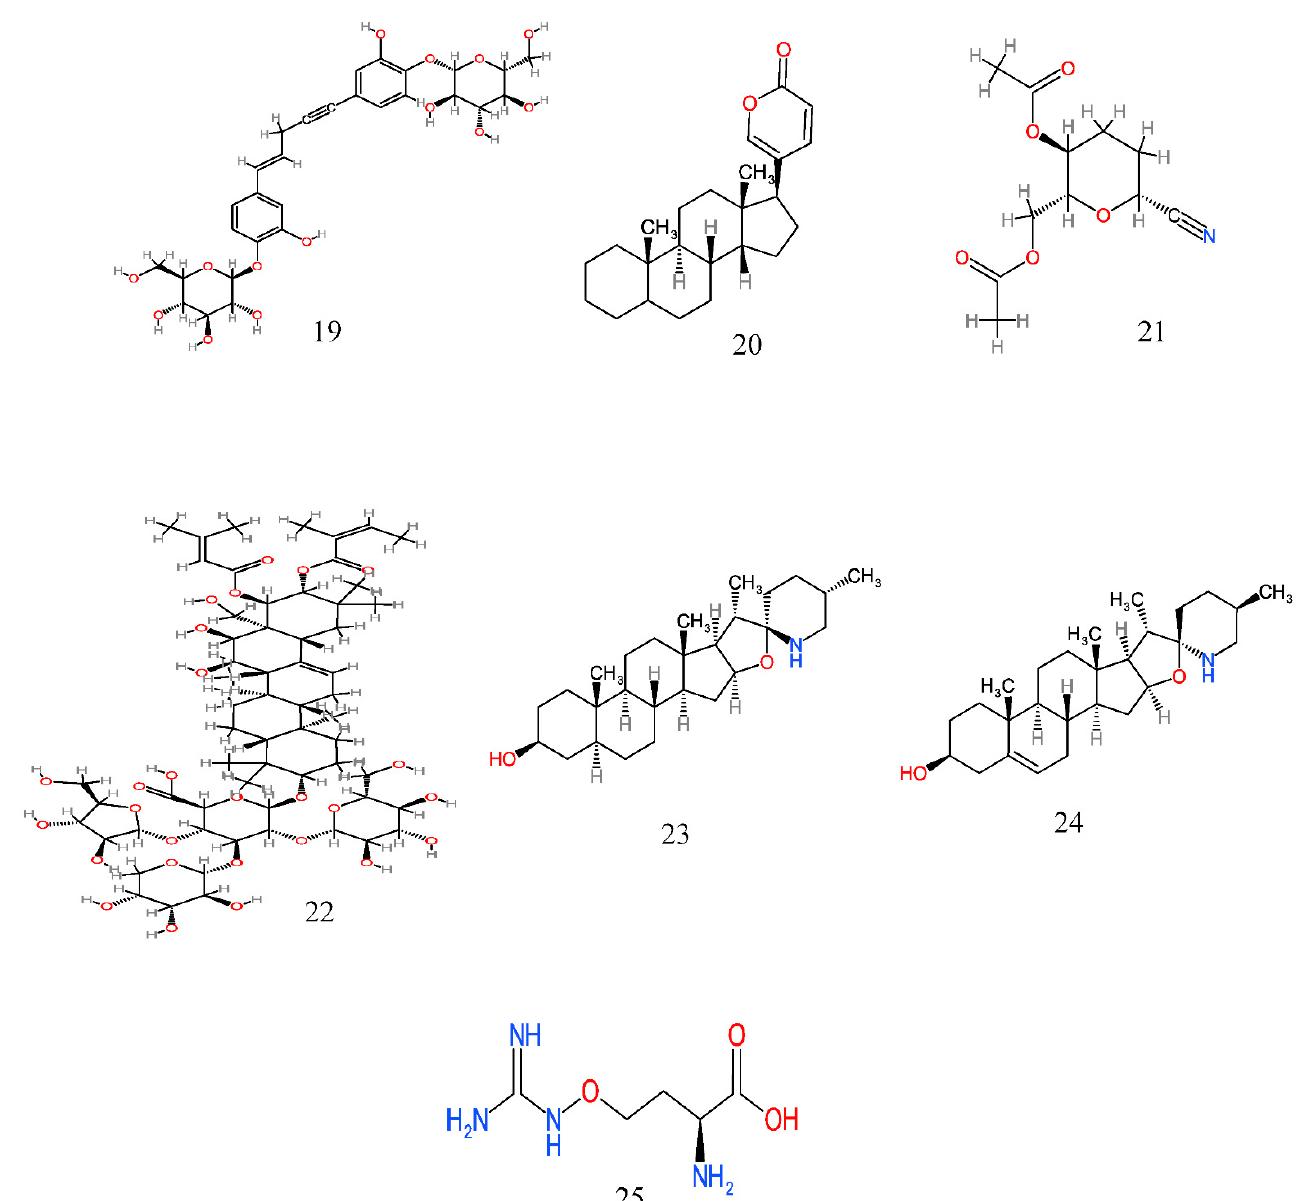
Figure 2. Anticancer molecules reported in some anticancer medicinal plants used in the Eastern Cape province, South Africa. The numbers 1–25 match the molecules reported in Table 3.